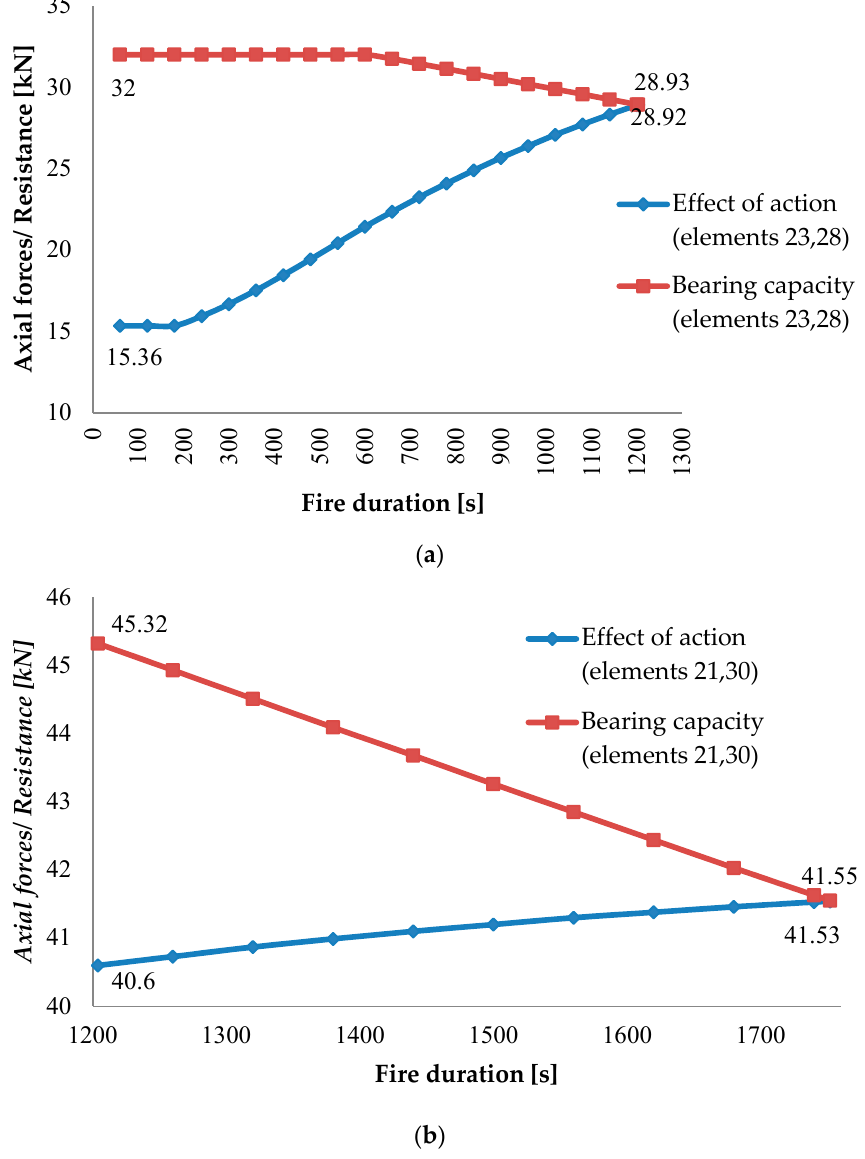
Figure 6. The change of axial forces and resistance with fire duration (truss “A”): ( a ) elements 23, 28 and ( b ) elements 21, 30.